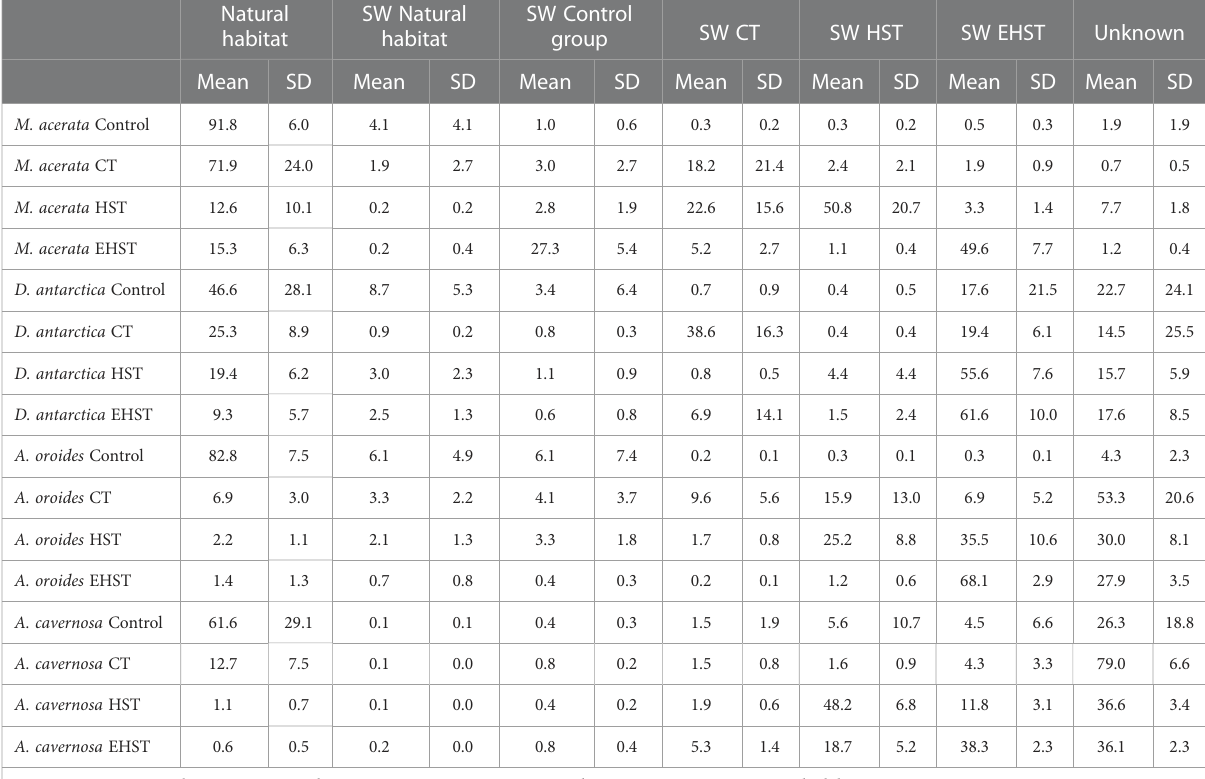
TABLE 3 Average contribution of reads (%) of the possible sources to the microbiome of the different sponge species experimental groups detected in the aquaria exposed at different temperatures. Natural